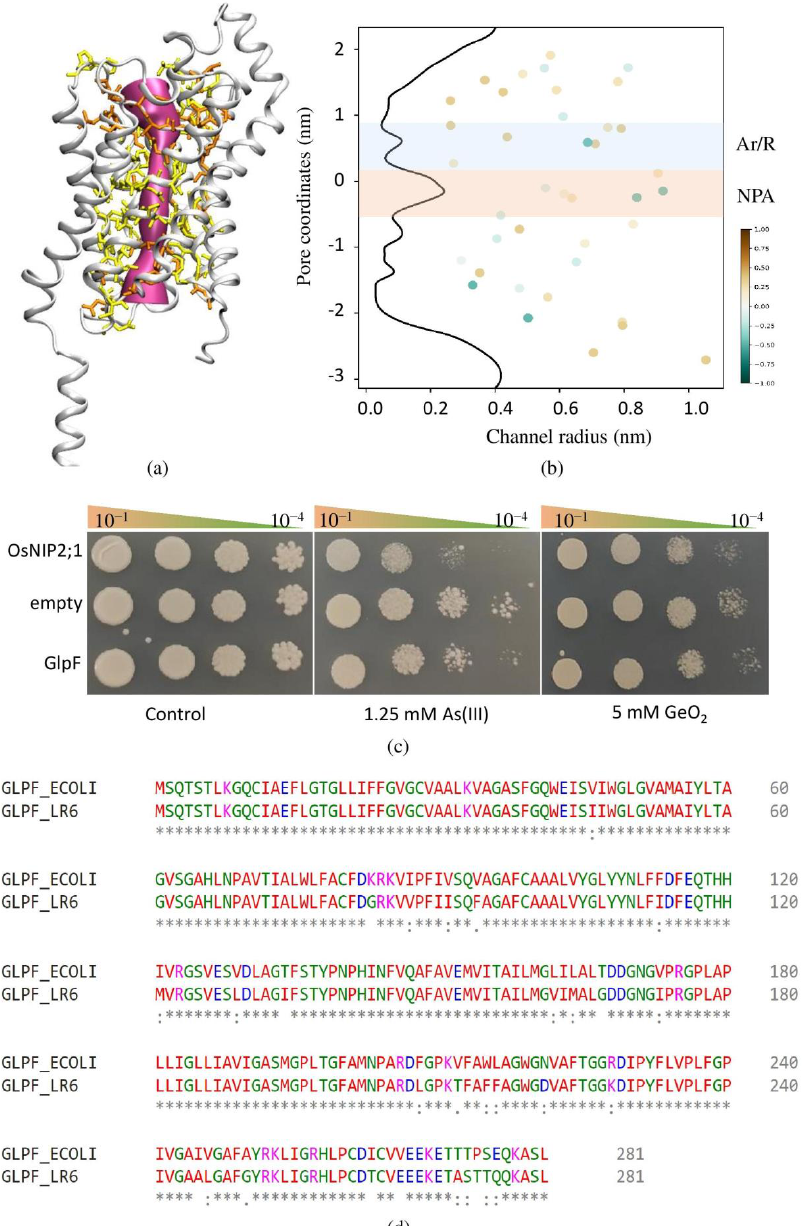
Figure 5. Three-dimensional structure of Enterobacter GlpF. Pore-facing residues are represented in orange, while the pore-lining residues are in yellow ( a ). The pore radius for predicted